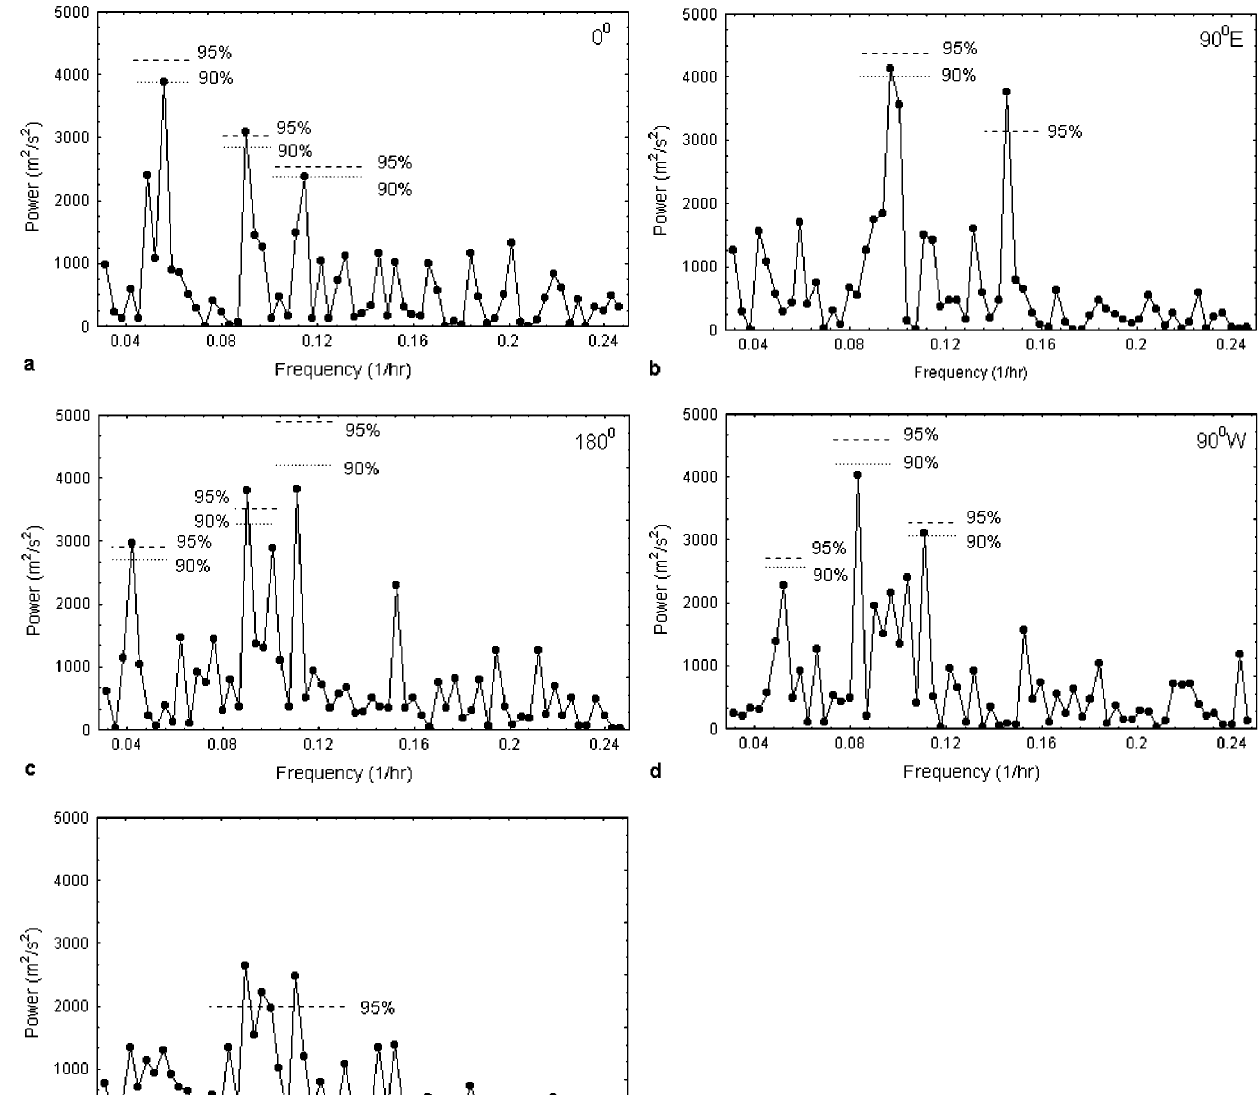
Fig. 1a–e. The periodgrams for the South Pole meteor radar wind measurements during the period June 19, 1995–June 30, 1995. a Measurement direction 0 (cid:176) ; b direction 90 (cid:176) E; c direction 180 (cid:176) ; d direction 90 (cid:176) W; e data averaged over